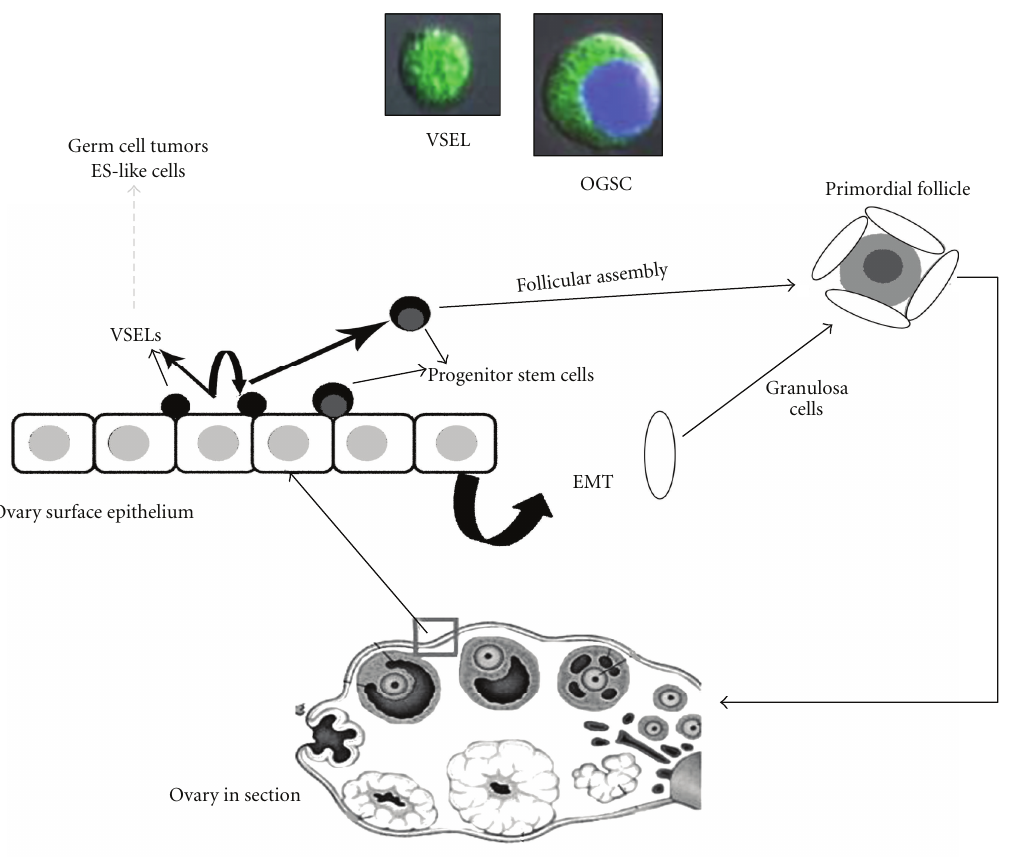
Figure 2: Proposed model for postnatal oogenesis in adult mammalian ovary. Pluripotent stem cells with nuclear OCT-4 (VSELs) being located in the ovary surface epithelium (OSE). These cells undergo asymmetric cell division and give rise to cells with cytoplasmic OCT-4 (OGSCs, which intensely stain with Haematoxylin). The OGSCs undergo further proliferation, meiosis, and di ff erentiation to assemble into primordial follicles in the OSE. The granulosa cells are formed by the epithelial cells that undergo epithelial mesenchymal transition [30]. As the follicles grow and further mature, they shift into the ovarian medulla. Confocal images represent VSEL and OGSC isolated by scraping the surface epithelium of perimenopausal human ovary